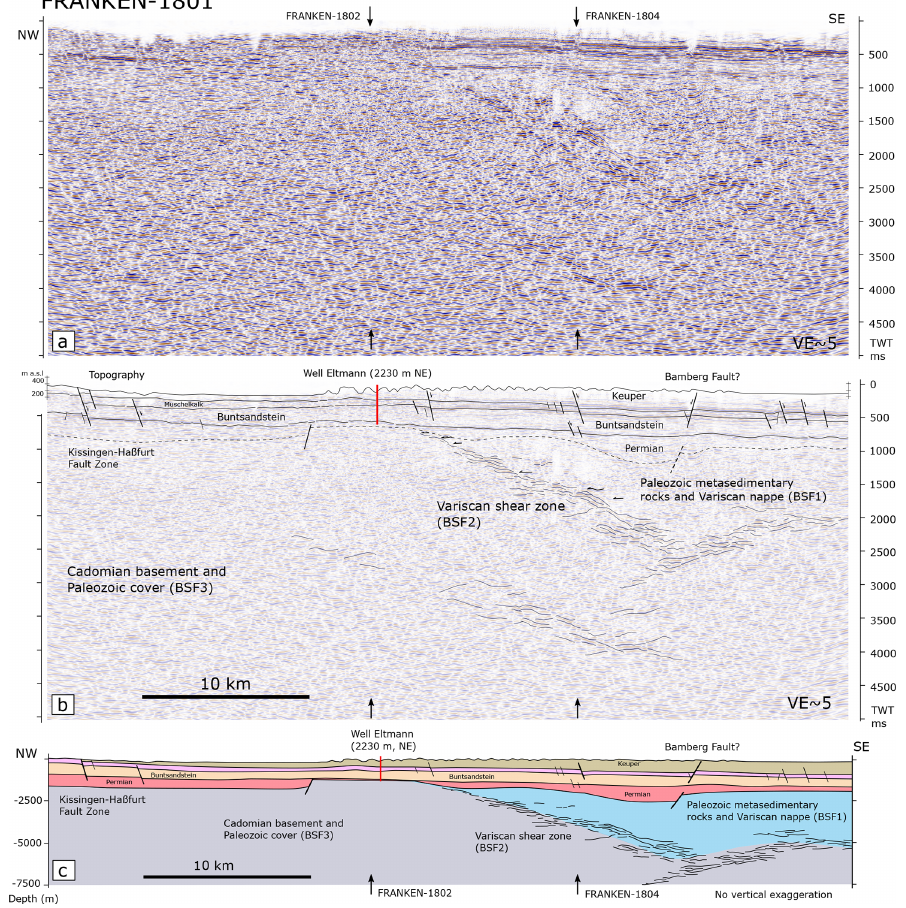
Figure 6. (a) Uninterpreted and (b) interpreted FRANKEN-1801 profile. Horizon interpretation is tied to drilled wells in the study area. (c) Depth-converted profile with no vertical exaggeration. Intersecting profiles FRANKEN 1802 and 1804 are shown by black arrows. See Fig. 1 for the profile